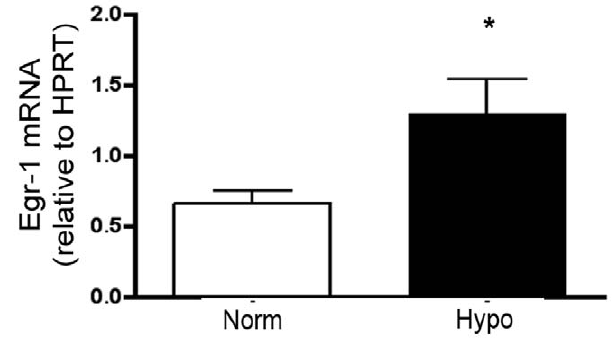
Figure 3. The redox-sensitive transcription factor Egr-1 is increased in the pulmonary artery of chronically hypoxic calves (Hypo) compared to age-matched normoxic control calves (Norm). Egr-1 mRNA expression was measured by qPCR in the pulmonary artery of 2 week old chronically hypoxic calves compared to age-matched normoxic control calves . Data are expressed as copies of Egr-1 per copy HPRT, mean 6 SEM. *p , 0.05 vs. Norm; n=4–5.